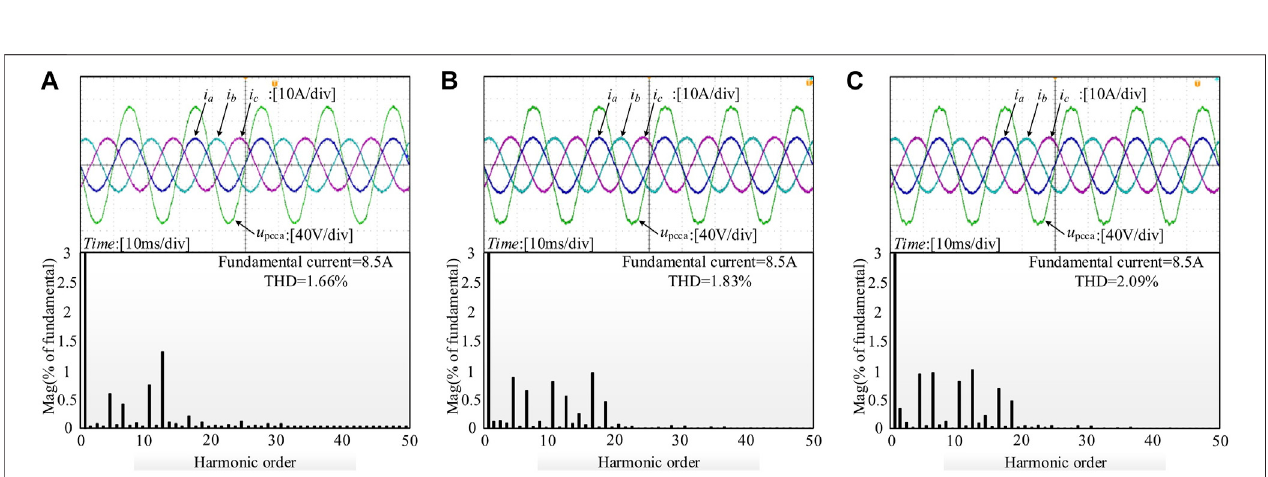
FIGURE9| Steady-stateexperimentalwaveformsoftheinverterat L g (cid:1) 1.5 mH: (A) withtheproposedmethodinthispaper, (B) withthemethodinLiuetal.(2020), and (C) with the method in Jiao and Lee (2015).